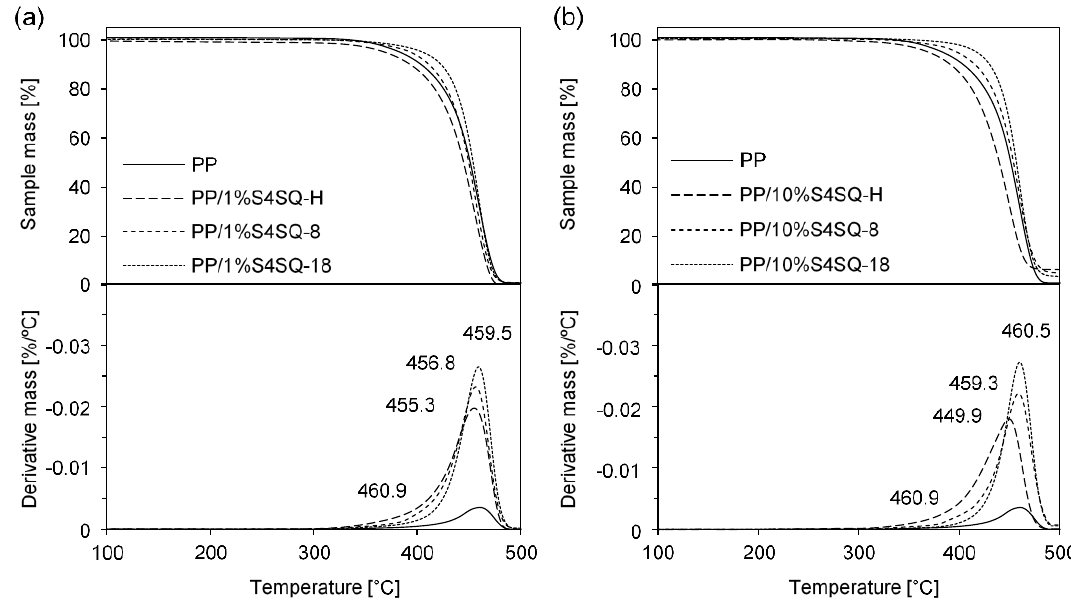
Figure 2. TG/DTG curves of neat PP as well as ( a ) PP/1%S4SQ and ( b ) PP/10%S4SQ composites (under nitrogen atmosphere).